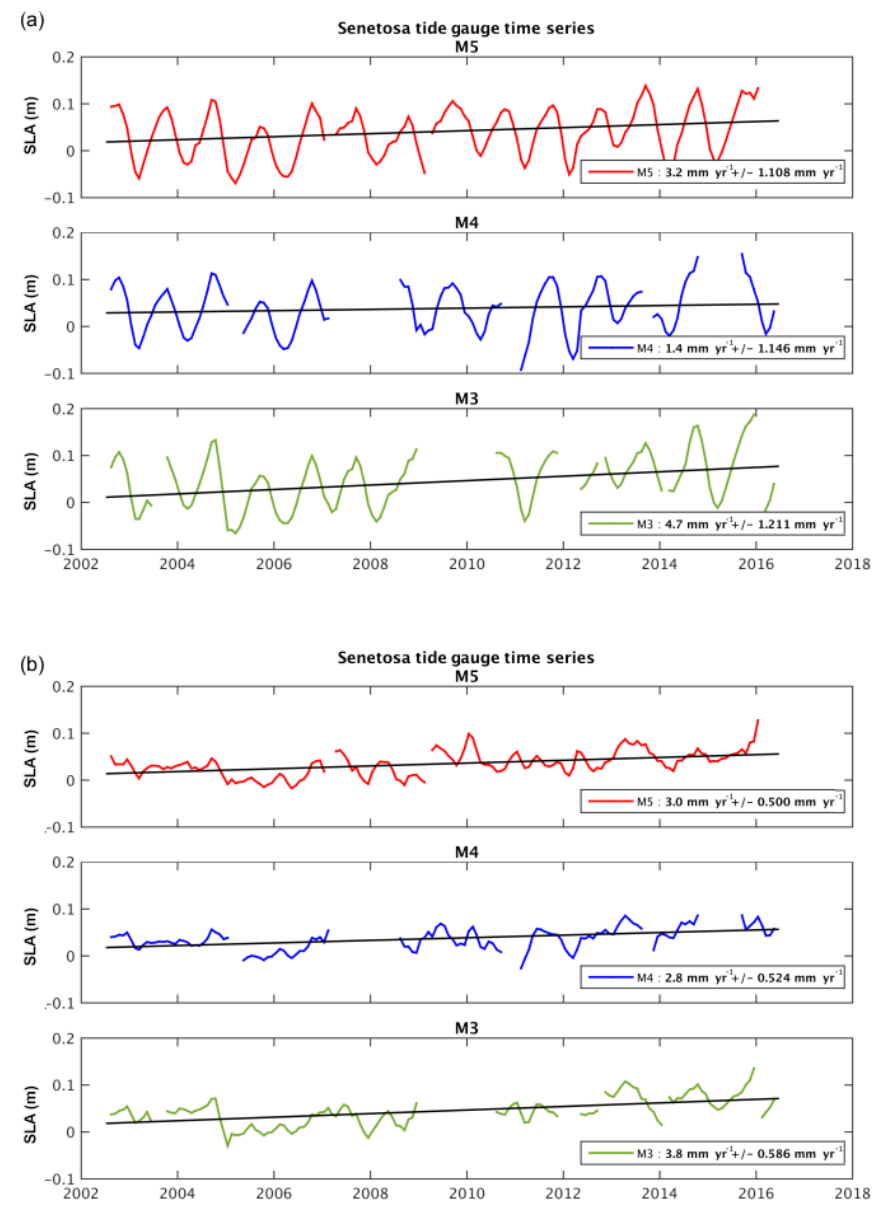
Figure 12. Sea level time series based on in situ tide gauge measurements at the M3, M4 and M5 sites over 2002–2016 (a) with the seasonal cycle and (b) without the seasonal